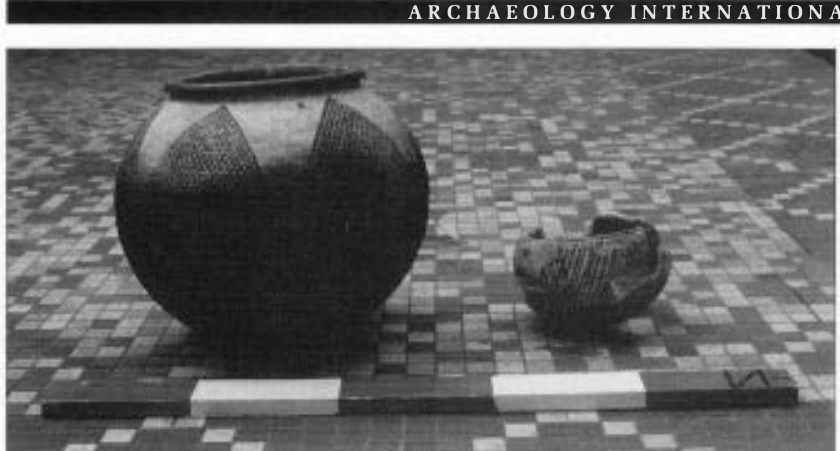
Figure 5 Two intact polychrome painted pots (white, black and red) from a Horizon 3 living floor at Tango Maan§ Diabal. Permanent structures at Tongo Maare Diabal consist of four types: curvilinear and rectilinear tauf or pise buildings, and curvilinear and rectilinear rectangular mud­ brick buildings. Beginning from the earli­ estoccupation (Horizon 1, AD 300-450) there are remains of curvilinear tauf houses, which are the earliest dated permanent domestic structures yet known in Mali. In the next two centuries (Horizon 2, AD 450- 650) rectilinear tauf and mudbrick struc­ tures appear, with some curvilinear struc­ tures continuing throughout the